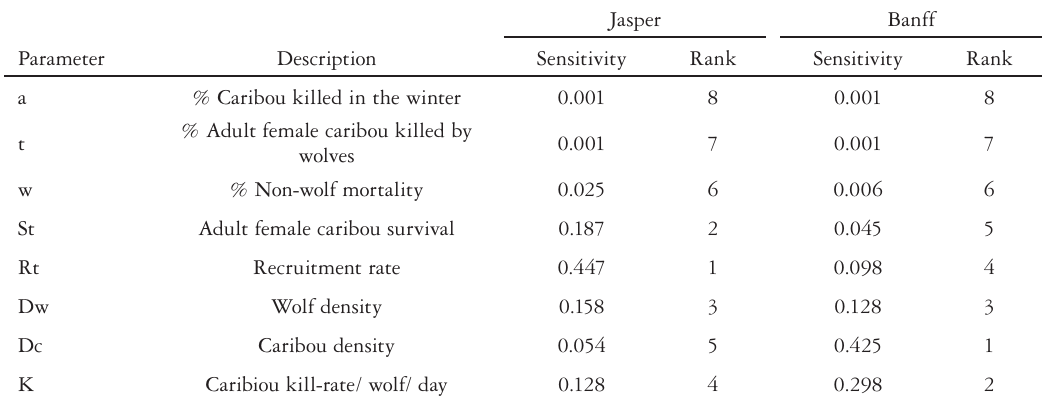
Table 3. Sensitivity analyses for eq. 3 revealing the proportion of the variance in population growth rate, λ , explained by parameters, for the southern Jasper and Banff caribou sub-populations, 2003-2004. Sensitivity was evaluated using one at a time proportional changes to each parameter holding effects of other parameters constant at the values reported in Table 1, and are reported as standardized sensitivities summing to